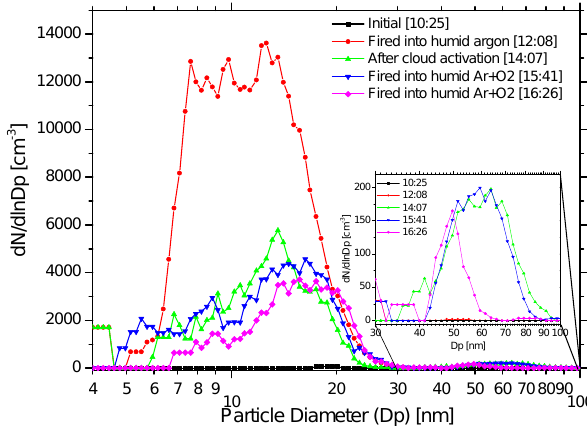
Fig. 2. Particle and trace gas formation by laser filaments for exper- iments 1&2 in pure argon and in an argon–oxygen mixture (15% O 2 ) at 283K and at 64% as well as 55% relative humidity, respec- tively. The panels show (a) aerosol particle number (black and red lines) and mass concentrations (blue circles); (b) relative humid- ity (black line), ozone (blue line), NO (dark green line), and NO x concentrations (light green line); (c) as well as near-forward scat- tering (black line), laser power (red line) and mixing fan operation (shaded grey area). Dashed vertical lines indicate the time of events like switching on/off the laser, the fan, or a pump.